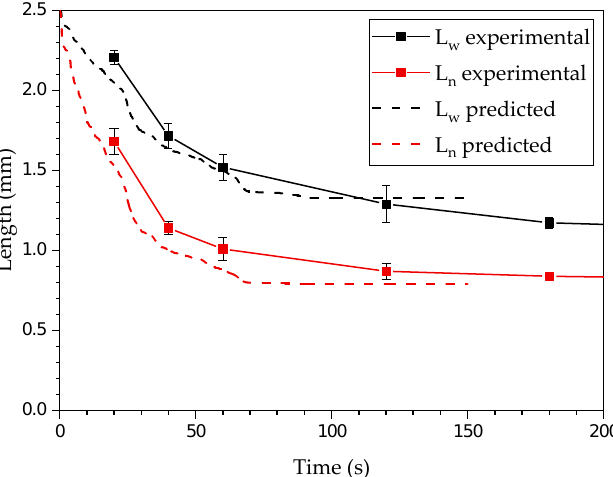
Figure 11. Fiber length evolution compared to the Couette flow experiment with fiber relaxation applied to the first second in simulation.